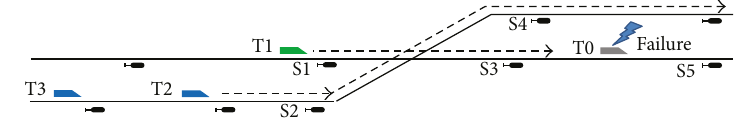
Figure 4: Example of giving up of occupancy [15].